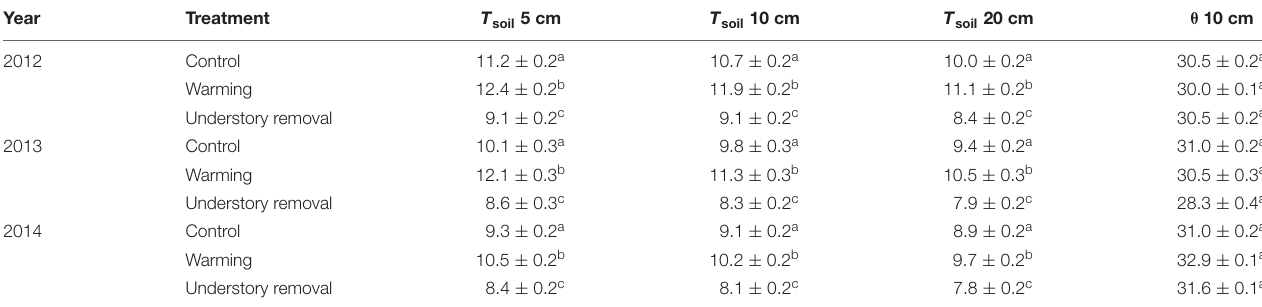
Values are the mean ± SE of four sensors per treatment. Different letters indicate significant differences at p < 0.05.